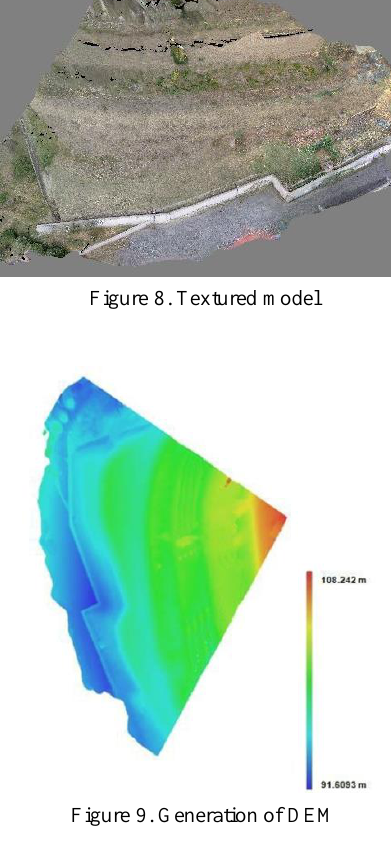
The computerized processing procedure from frames to model 3D (at each moment) is carried out according to a predetermined order in different phases (spatial modeling). The first phase is that of alignment of the images and of the construction of the sparse point cloud (cloud points basis). This step identifies the common points in both frames using the image matching algorithms. The points selected in the various photos must necessarily have some features in common for properly overlapping. The result is an overall view of all shooting points positioned along the three Cartesian axes (local reference system) and the points constituting the sparse points cloud. The construction of the denser point cloud (dense cloud points) represents the second stage of processing, in which starting from the cloud of sparse points we get a more detailed and dense cloud of points. The realization of the mesh allows obtaining a polygonal mesh of the sea surface, while the construction of the texture is the last step that allows to “coating” the polygonal mesh generated in the previous step using the color data of the uploaded images. The texture is, in fact, a set of points, lines, and shapes that give the overall impression of a compact surface, making it as realistic 3D model so far obtained. The 3D model with texture obtained is subsequently scaled and geo-referenced using data collected on the structure supporting the camera site (Barrile, Bilotta, Pozzoli, 2017). The temporal combination of the obtained models (space-time modeling) is made by appropriate algorithm implemented in own on